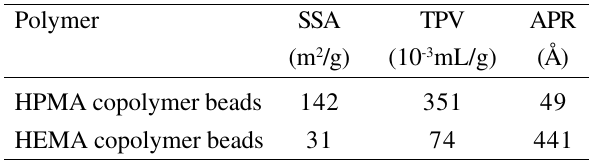
Table 1. NSA and MIP results (specific surface area, SSA, m 2 g -1 , total pore volume, TPV, average pore size, APR) for HPMA and HEMA copolymer beads,